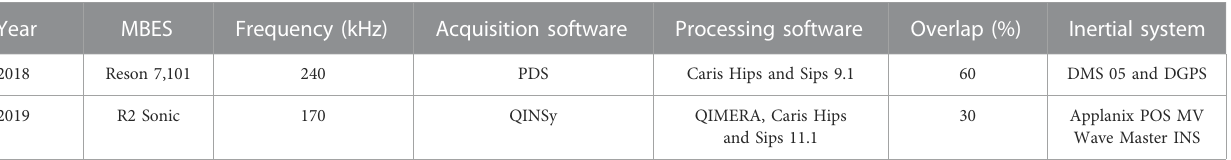
TABLE 1 MBES survey con fi